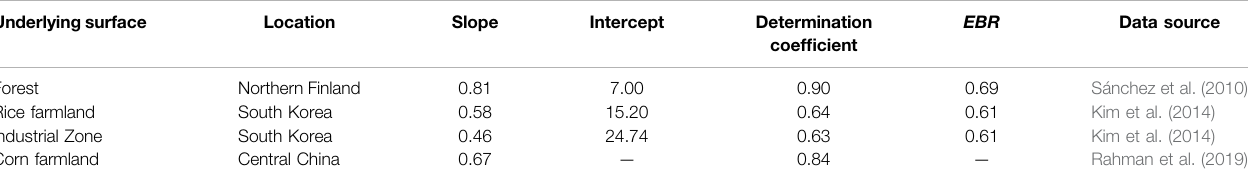
TABLE 3 | Energy closure of different underlying surfaces. EBR is the energy balance ratio, and “—” indicates that no speci fi c value was given in the original text. Underlying surface